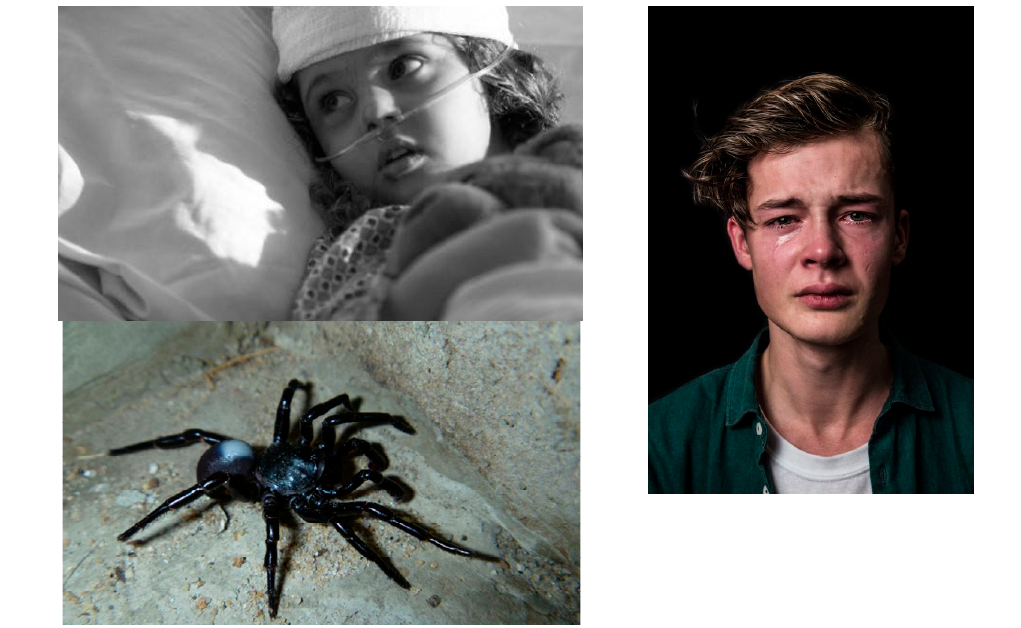
Figure A1. Positive emotional stimuli.